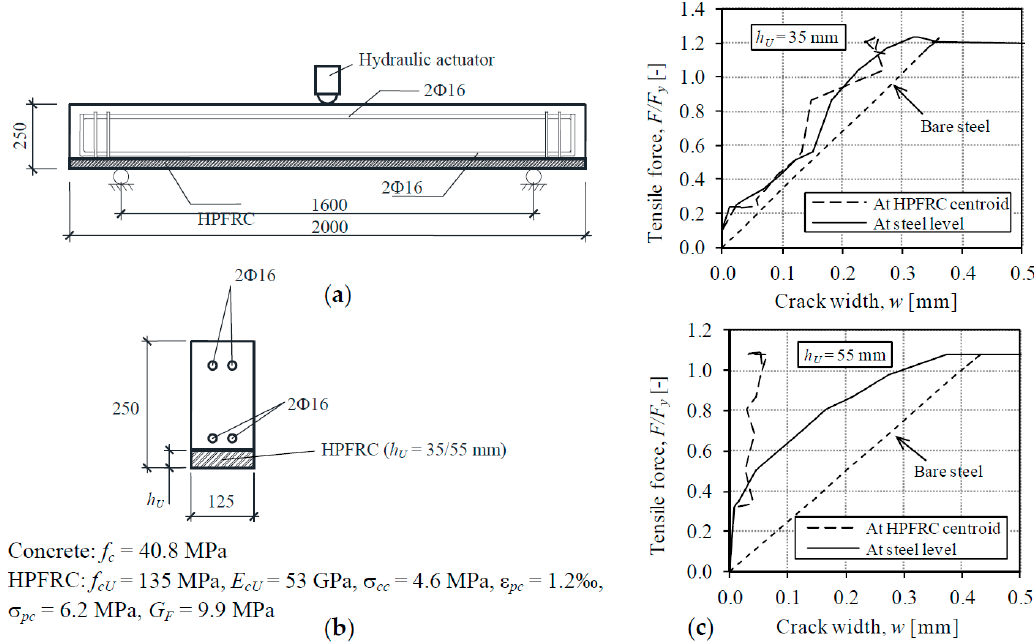
Figure 15. Analysis of crack evolution in previous beam tests [25]. ( a ) Dimensions in mm; ( b ) Cross-section and material properties; ( c ) Load-crack width at the tension chord of beams.